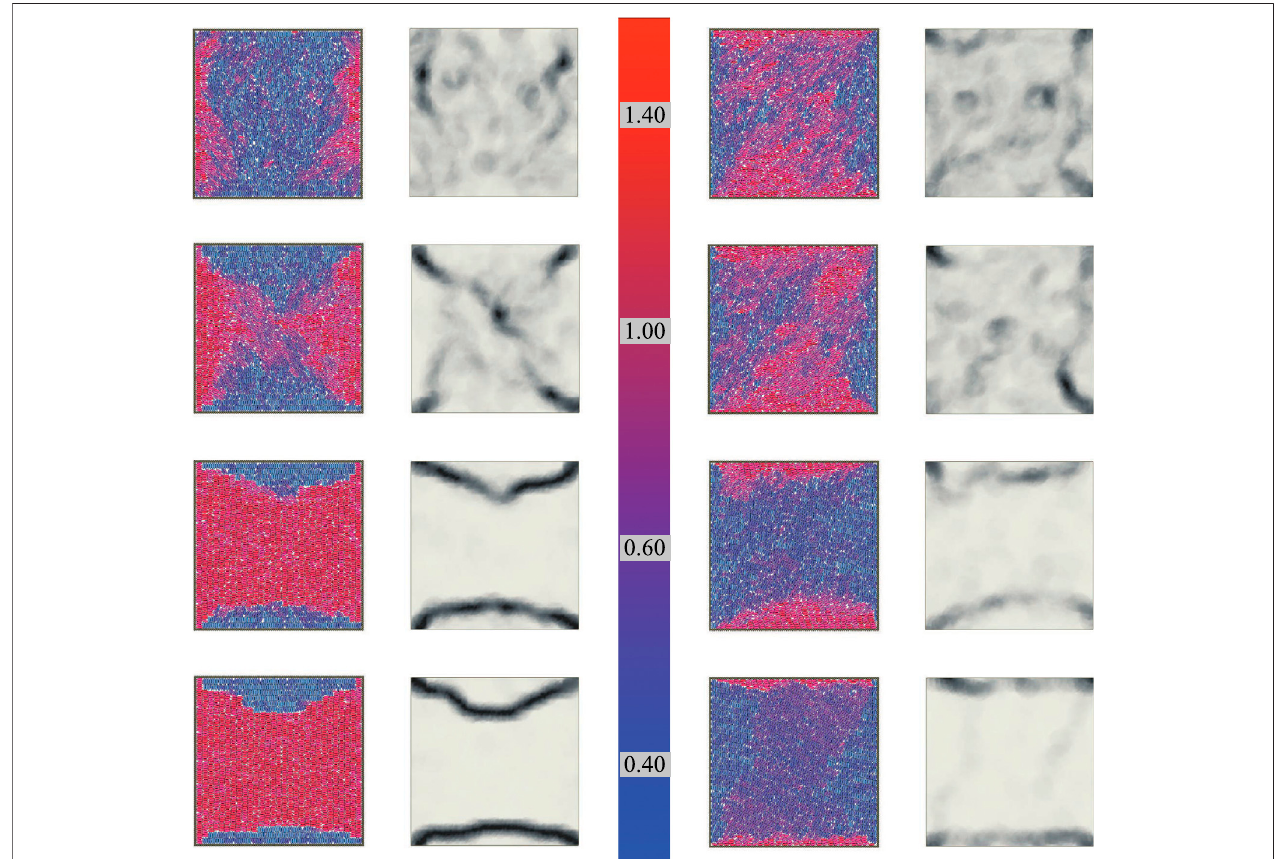
FIGURE 8 | The 2D GB ( 3 , 5 , 2 , 1 ) mesogen system con fi ned by a square boundary. Data are arranged as in Figure 7 .